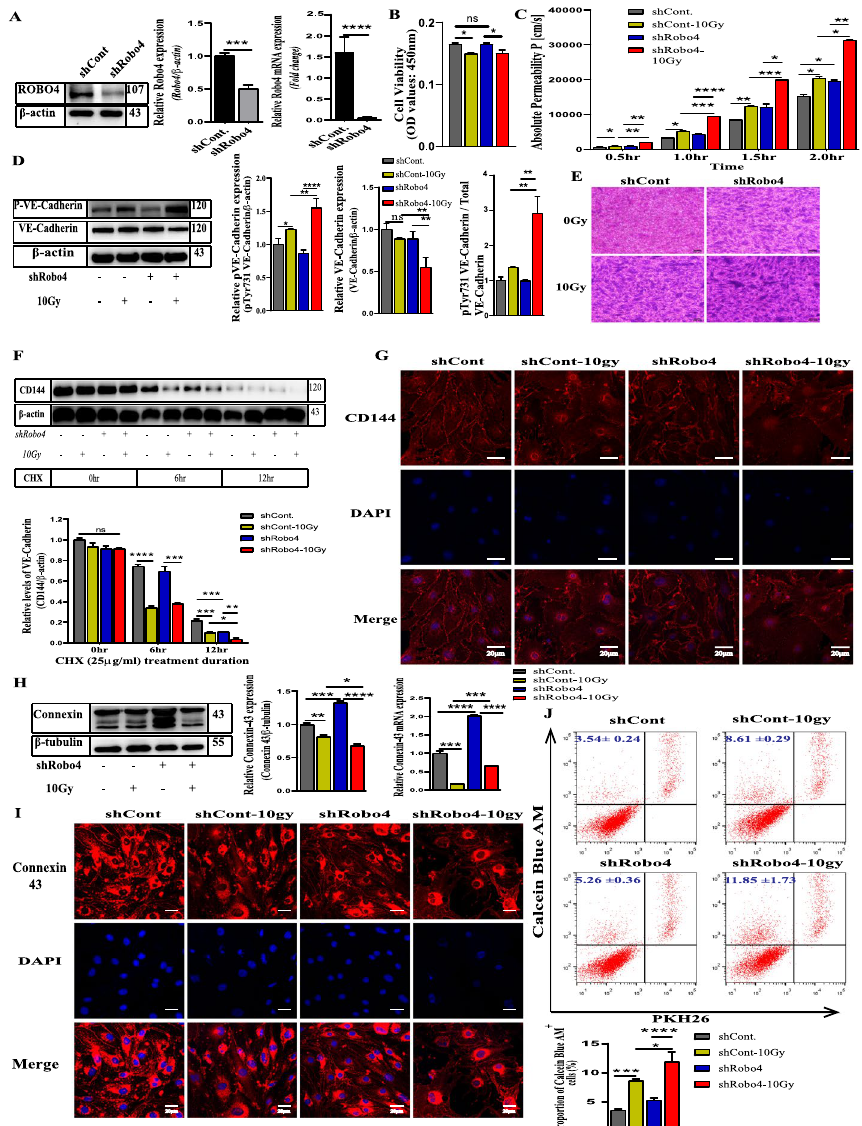
Fig. 2 Robo4 knockdown depletes the VE-cadherin expression and increases EC monolayer permeability following irradiation. Establishment of a microvascular ECs line with Robo4 stable knockdown. A Western blot and RT-qPCR analysis to confirm the reduced expression of Robo4 using beta-actin as an endogenous control. B Effect of Robo4 silencing and irradiation on cell survival and proliferation of ECs. C and E Fitc-labeled dextran-40 kDa permeability assay and Transwell endothelial monolayer crystal violet staining results following Robo4 knockdown and gamma radiation treatment. D Immunoblotting analysis of total and phosphorylated Y-731 VE-cadherin in Robo4 silenced microvascular ECs after irradiation; The relative protein expression of phosphorylated Y-731 and total VE-cadherin normalized with endogenous beta-actin protein; the ratio of phosphorylated Y-731 VE-cadherin to total VE-cadherin using image J software for quantification. Cycloheximide treatment and immunoblotting were conducted as in ( F ). The CD144 band intensity was normalized to actin and then normalized to the t 0 controls. G Confocal microscopic images of VE-cadherin = (red) and 4’,6-diamidino-2-phenylindole (DAPI) staining (blue). H Western blot and qPCR analysis showing connexin 43 expression levels in Robo4 knockdown microvascular ECs following gamma radiation treatment. I Confocal images show immunofluorescence of connexin 43 (red) in Robo4 knockdown microvascular ECs, with or without irradiation. Nuclei appear in blue. Scale bars 20 µm. J Flow cytometric analysis to determine = endothelial GJs coupling ability in vitro. For all experiments, n 3, and error bars represent std. * P < 0.05, ≥ ** P < 0.01, *** P < 0.001, **** P <